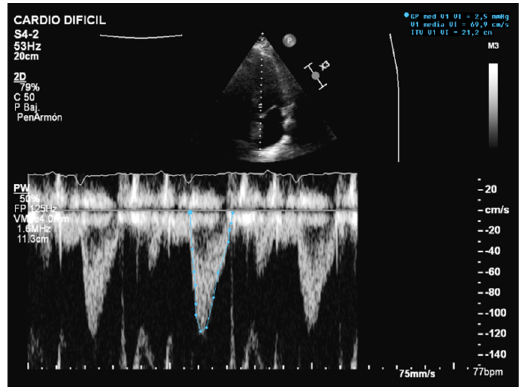
Figure 3. Normal left-ventricular outflow tract velocity integral (VTI).